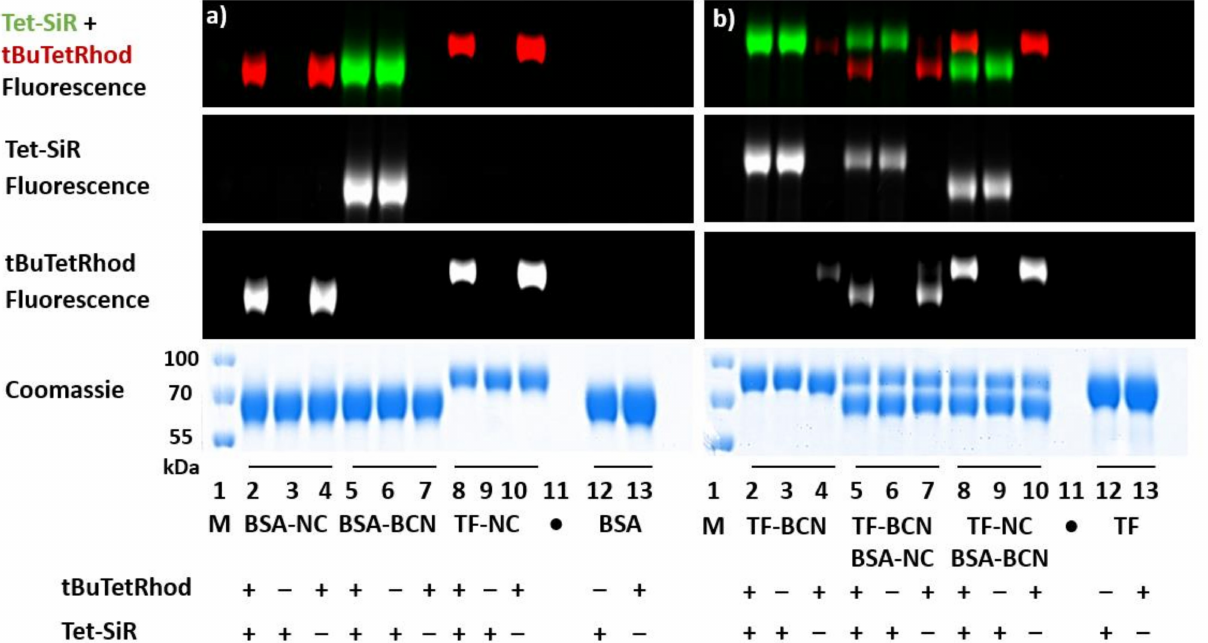
Figure 1. Bioorthogonal labeling of serum proteins Transferrin (TF) and Bovine Serum Albumin (BSA) to test mutual orthogonality between IEDDA and [4 + 1] cycloaddition represented by in-gel fluorescence imaging of SDS-PAGE gels. TF and BSA were modified with NHS-NC and NHS-BCN . Top images are overlays of the Tet-SiR and tBuTetRhod channels. Images in the middle two rows are the individual fluorescent channels, Coomassie staining is found in the lower row. Molecular weight corresponding to the three visible bands of the marker are indicated. Panels ( a , b ) represent the two gels that contain all combinations of labeling reactions. All reactions were run parallel and both of the gels in ( a , b ) were run together in the same